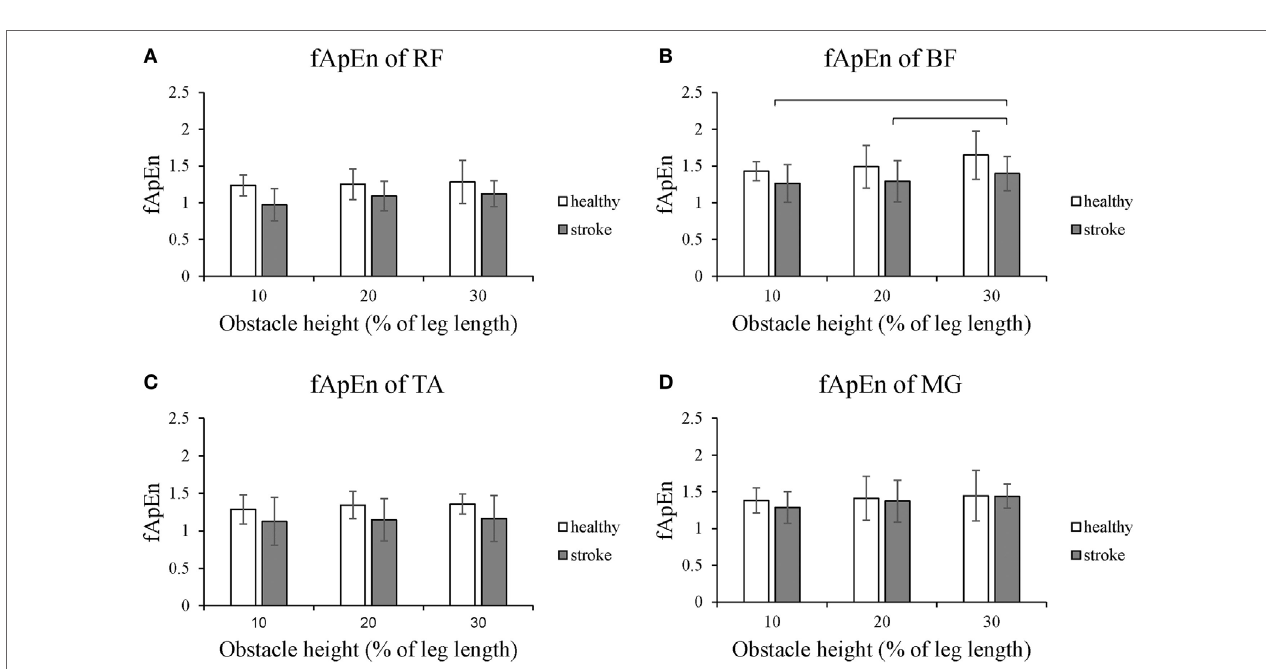
FigUre 5 | The details of fuzzy approximate entropy (fApEn) values of each height for leading limb during stance phases. (a) The fApEn values of rectus femoris (RF); (b) the fApEn values of biceps femoris (BF). (c) The fApEn values of tibialis anterior (TA); (D) the fApEn values of medial gastrocnemius (MG). The bar (-) indicates significant effect between